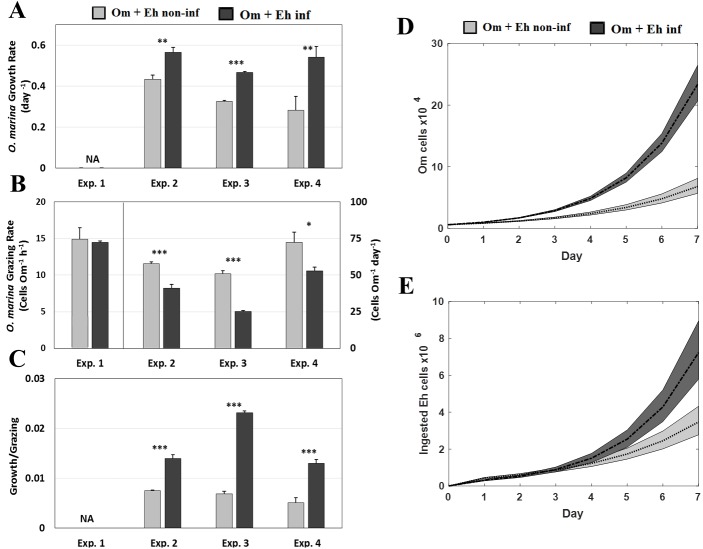
Growth and grazing rates.Differentialgrowth and grazing rates of O. marina fed non-infected versus infected E. huxleyi. (A) O. marina growth rates (day −1). (B) O. marina grazing rates (Eh cells Om −1h−1 (Exp. 1) or Eh cells Om −1 day −1 (Exps. 2–4); see Table 1). (C) O. marina growth rate divided by grazing rate (O. marina divided per E. huxleyi consumed). Values mean ± one standard deviation (Experiments 2, 3, and 4) and standard deviation (Experiment 1). (D) Projected O. marina’s population size at each time point. E: Projected total consumption of E. huxleyi cells at each time point. Dashed lines are average values and shaded regions are one standard error from Experiments 2, 3, and 4. Asterisks indicate statistical significance: *** p < 0.001, ** p < 0.01, * p < 0.05.